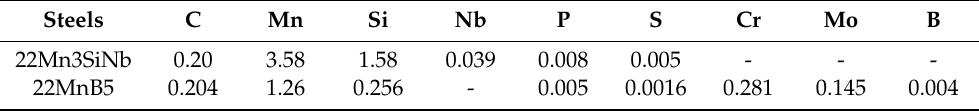
Table 1. Chemical composition of the investigated steels (mass fraction, %).